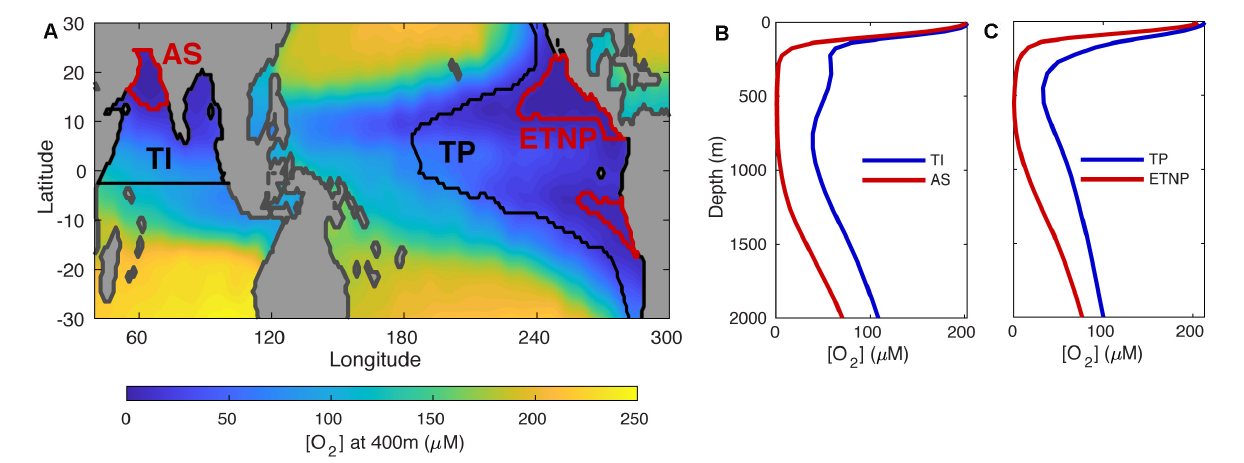
FIGURE 1 | Regions used in our flux reconstruction analysis. (A) Contour map of annual-mean oxygen concentration at 400 m depth in the low latitude ocean, from the World Ocean Atlas 2013 (Garcia et al., 2013). Black and red contours delineate the regions over which reconstructed particle flux profiles are averaged. The areas inside of the black contours in the Indian and Pacific Oceans are defined as the oxygenated Tropical Indian (TI) and Tropical Pacific (TP) averaging regions, respectively, with the exception of the areas inside of the red contours, which enclose suboxic waters with [O 2 ] < 5 µ M at 400 m. These are defined as the OMZ averaging regions – Arabian Sea (AS) and Eastern Tropical North Pacific (ETNP). In the South Pacific, the area inside of the red contour is not incorporated into the TP region, but is not defined as independent averaging region because it spans too few gridcells on our model grid. (B) Depth profiles of annual-mean [O 2 ] averaged across the TI and AS regions. (C) , same as (B) but for the TP and ETNP